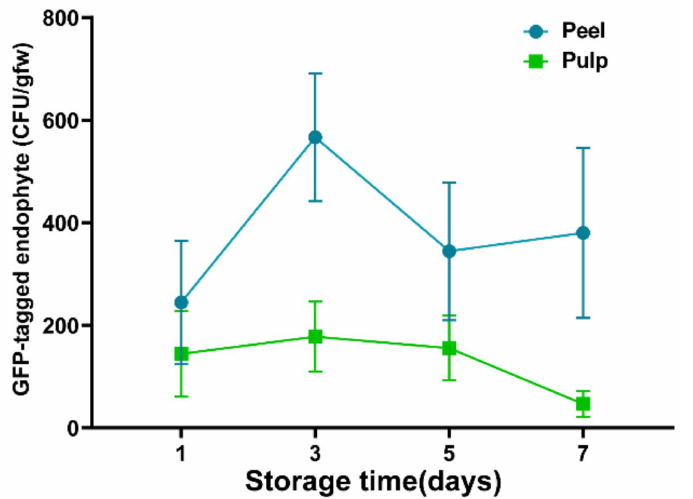
Figure 9. Colonization of Bacillus subtilis L1-21 on citrus fruits at different times. GFP-tagged endophyte L1-21 was used in this experiment to check the efficient